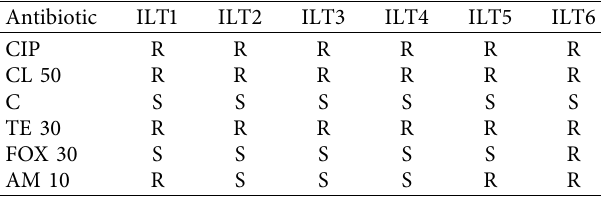
Table 5: Antibiogram determined by antibiotic discs of selected strains of lactic acid